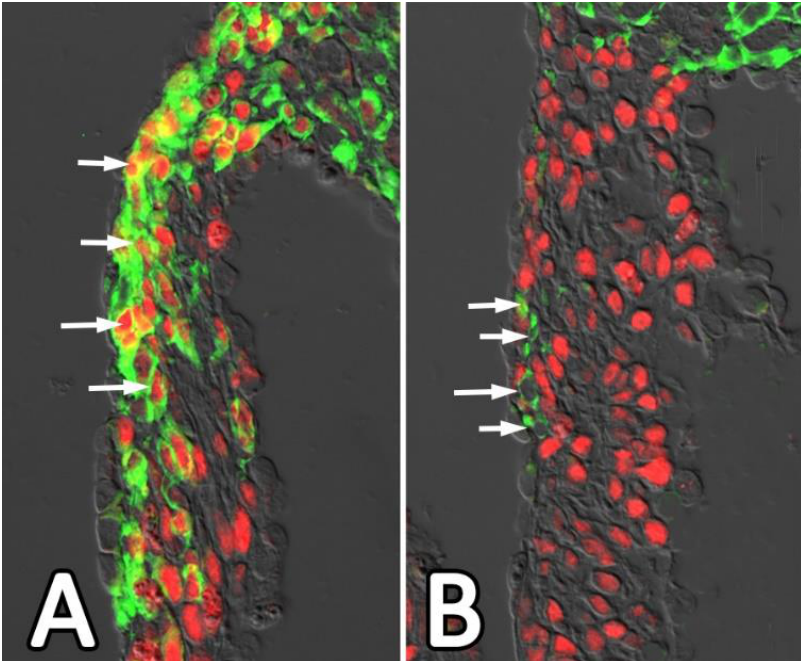
Figure 10. AV-EPDCs (green) in posterior leaflet of the mitral valve in control ( A ) and WT1 cre ;SOX9 fl/fl ; R26 mG ( B ) specimens at 17.5 ED. The sections are stained for the presence of EGFP (in green), indicating the presence of EPDCs and SOX9 (red). Note the abundance of SOX9-positive AV-EPDCs in the leaflet of control heart (arrows in ( A )) and virtual absence of AV-EPDCs in the posterior leaflet of the knockout heart ( B ). The few AV-EPDCs that are found in this leaflet do not express SOX9 (arrows in ( B )). Note also that EGFP-positive EPDCs in the top right corner of ( B ) do not express SOX9.